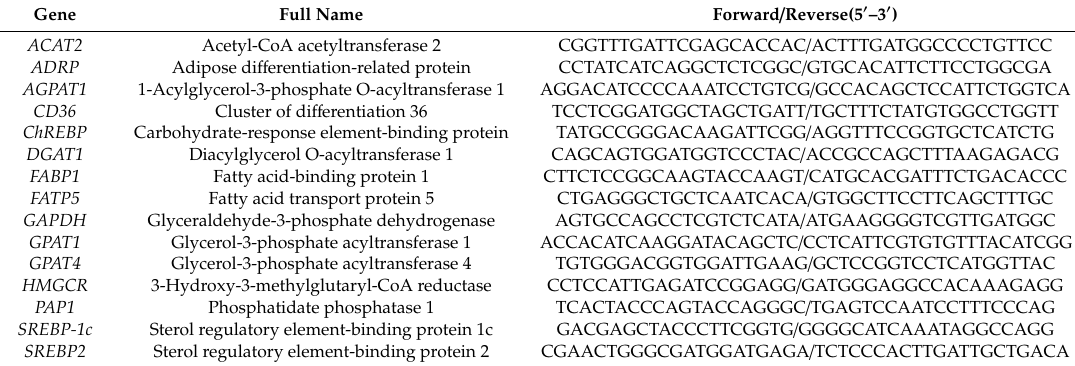
Table 1. Primer sequences for real-time